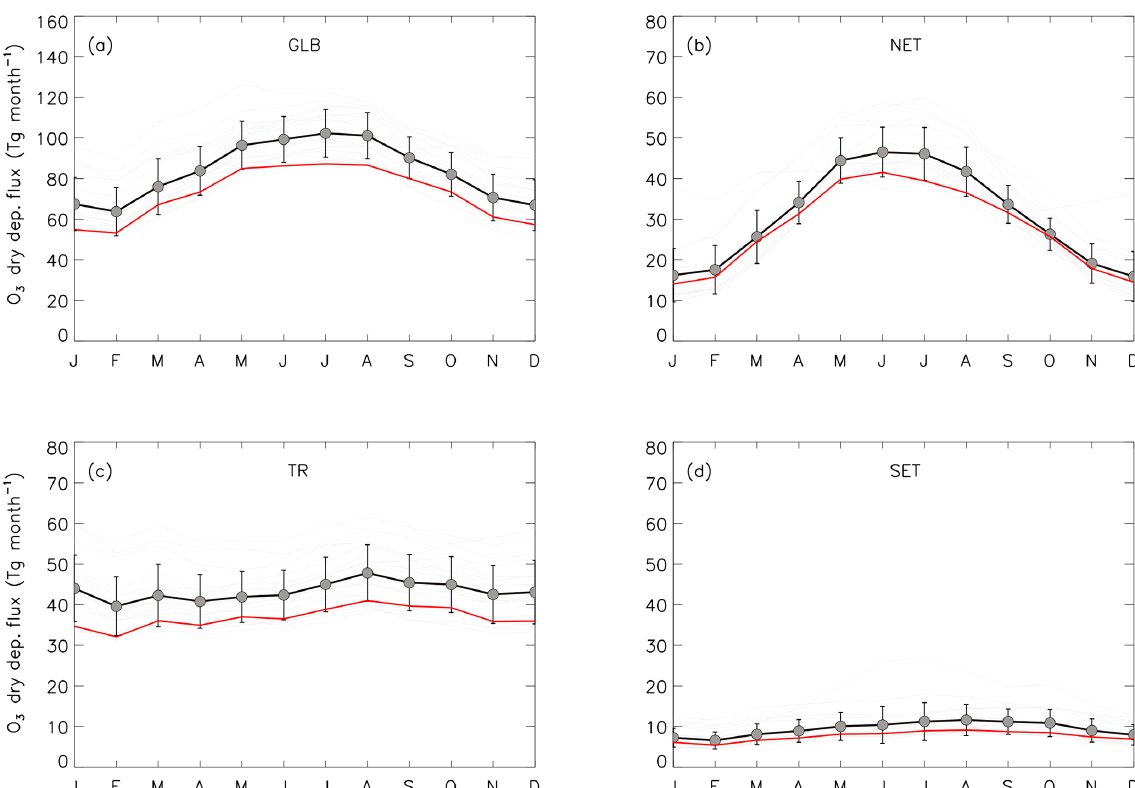
Figure 8. Multi-annual average monthly mean O 3 dry deposition fluxes for the global domain (a) and three latitudinal sections (b–d) for 15 models participating in the HTAP model intercomparison: northern extratropics (NET; 90–30 ◦ N; b ), tropics (TR; 30 ◦ N–30 ◦ S; c ) and southern extratropics (SET; 30–90 ◦ S; d ). The multi-model ensemble average (solid black line and filled circles) and single-model monthly means (grey solid lines) were provided by Hardacre et al. (2015). Error bars indicate ± 1 σ in the single-model monthly means. The solid red line shows UKCA ND StratTrop multi-annual average (2005–2014) monthly mean O 3 dry deposition fluxes (figure based on Hardacre et al.,